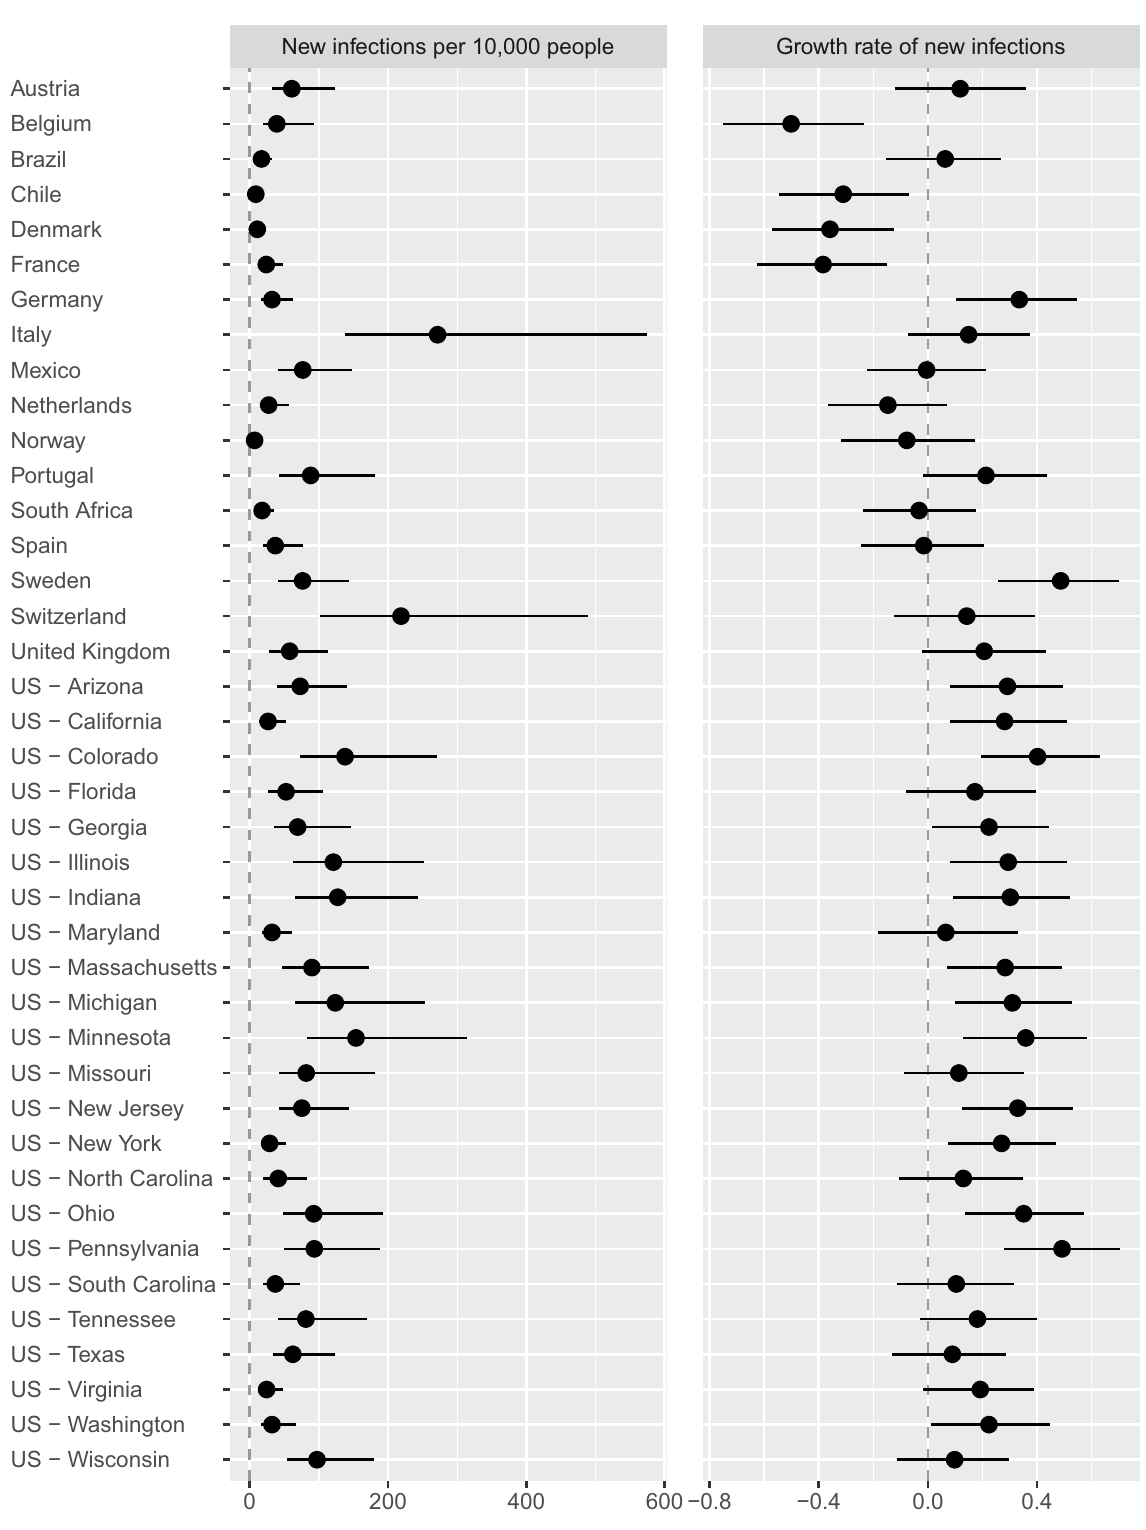
Fig 4. Weekly rate of new infections and their growth by jurisdiction as of November 22, 2020. Dots = median estimates; Lines = 95% intervals.